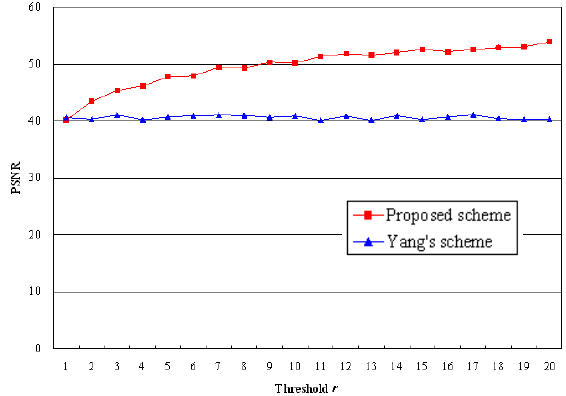
Fig. 7. Stego image quality with different